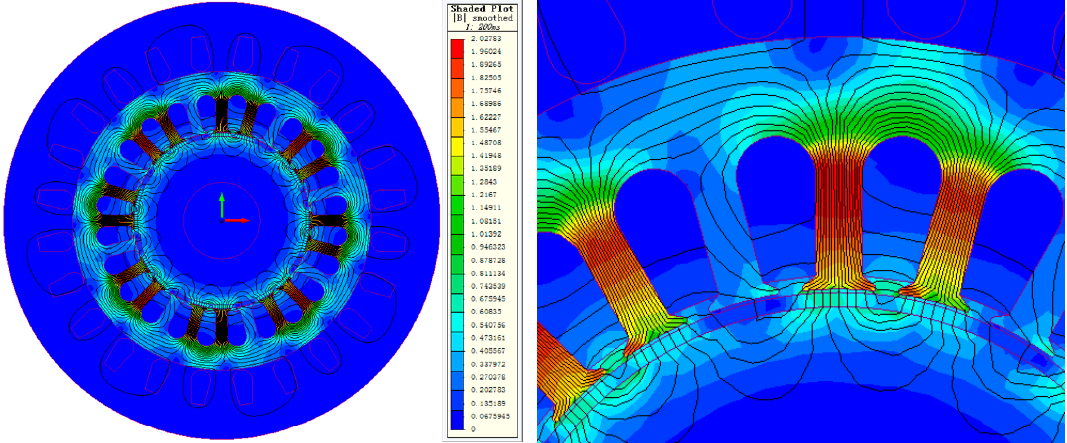
Figure 10. 2D copper plating model of the N-TWSRIM.